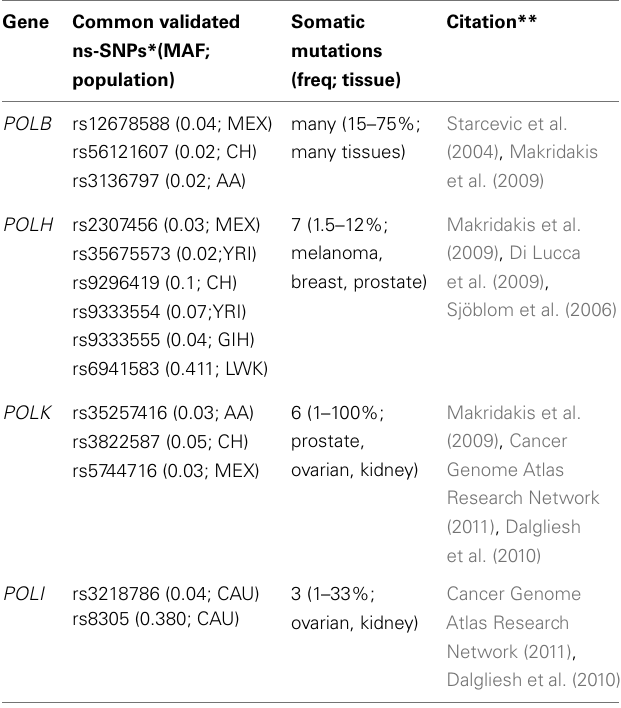
Table 2 | Genetic variants of translesion synthesis DNA polymerase